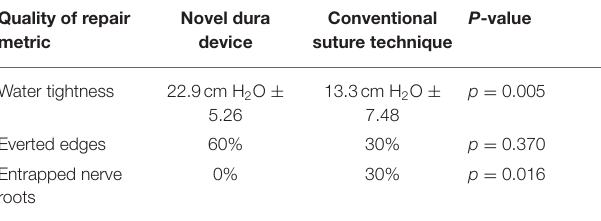
TABLE 3 | Novel dural repair